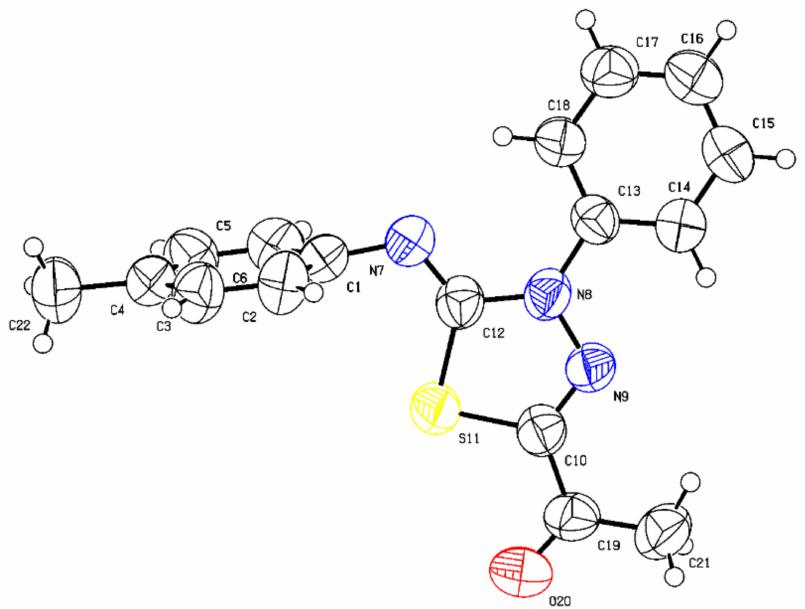
Figure 8. Thermal ellipsoid plots of ( Z )-1-(4-phenyl-5-( p -tolylimino)-4,5-dihydro-1,3,4-thiadiazol-2- yl)ethan-1-one ( 88 ) with ellipsoids drawn at 50% probability level (Deposition Number 2178551 ). For bond distances (Å) and angles (deg), see the Supplementary Materials Section